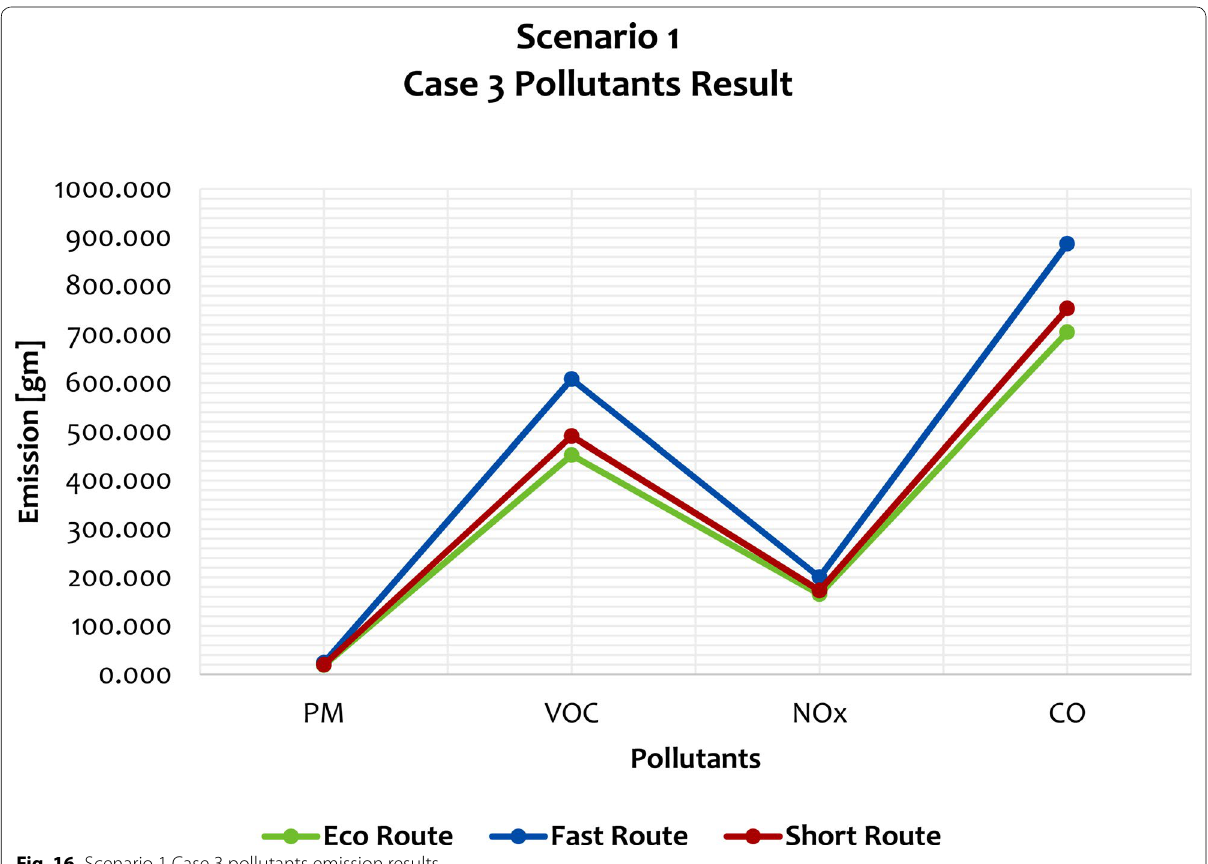
Fig. 16 Scenario 1 Case 3 pollutants emission results